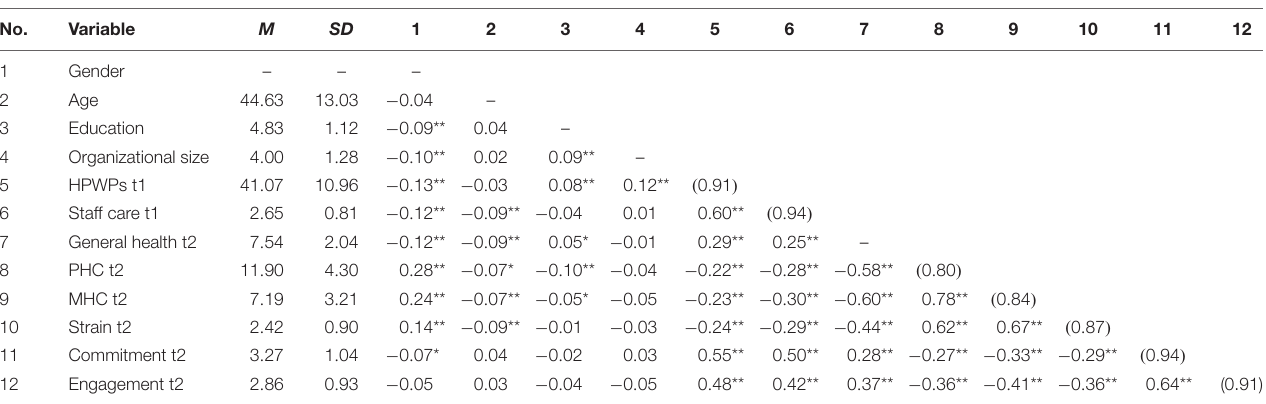
TABLE 1 | Descriptives and correlations of the study